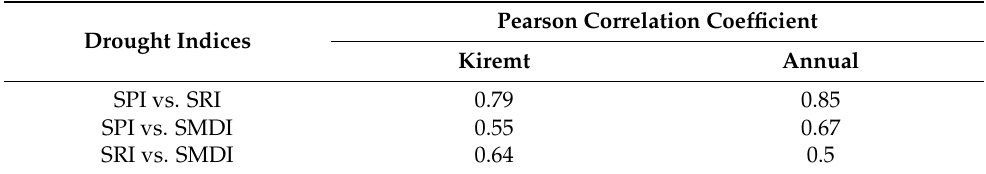
Table 4. Pearson correlation coefficient between drought indices for Kiremt and annual time scales.